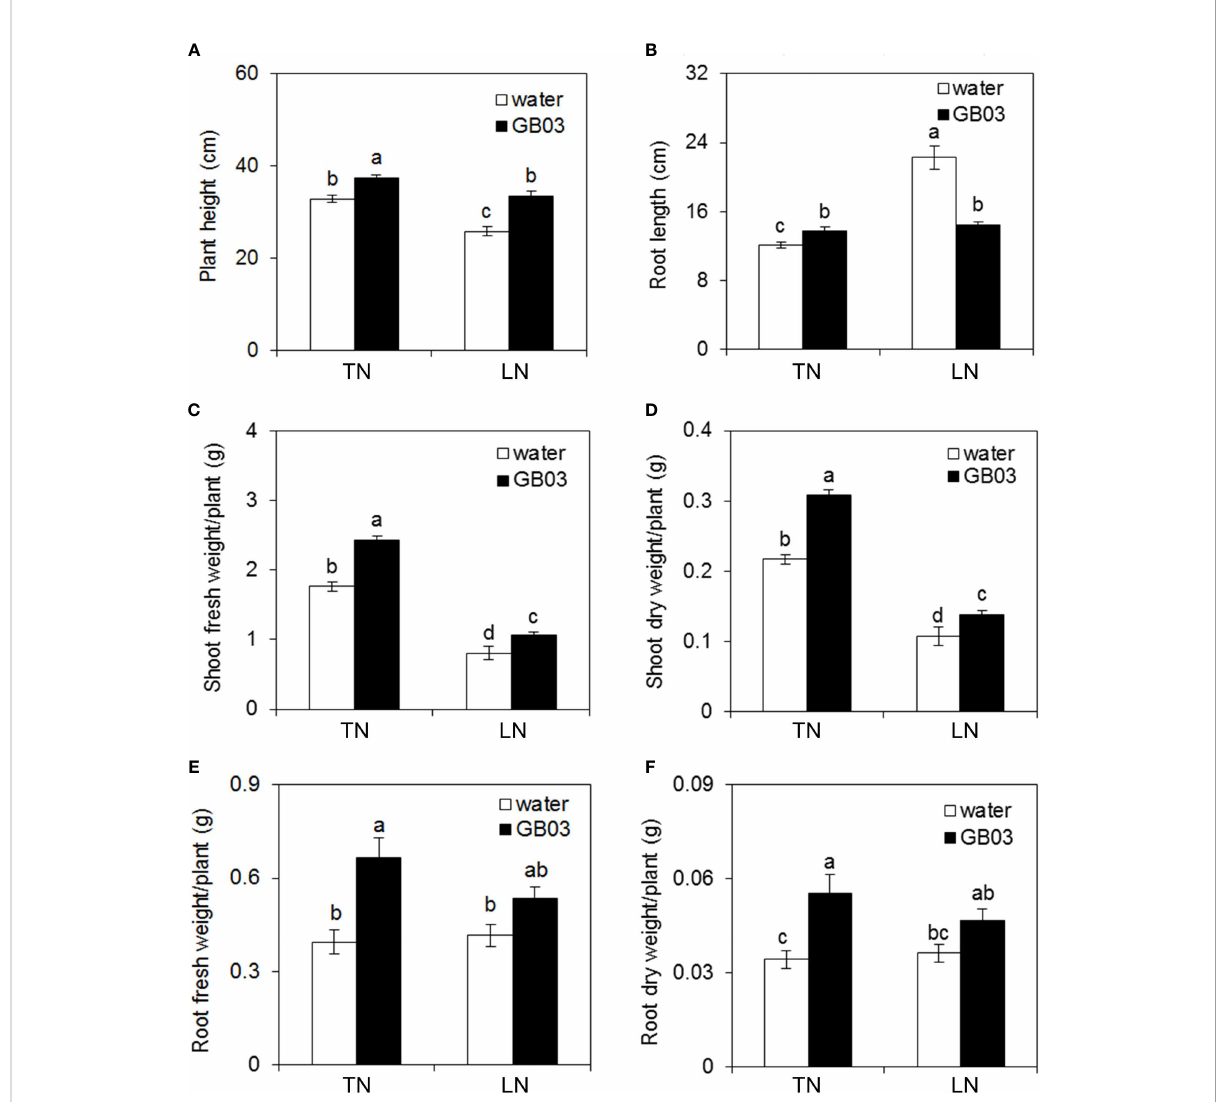
FIGURE 2 Effects of GB03 on tall fescue growth under various concentrations of NO 3- . (A) Plant height, (B) root length, (C) shoot fresh weight, (D) shoot dry weight, (E) root fresh weight, and (F) root dry weight. Values are means ± SE (A and B n = 30; C-F n = 8), and bars indicate SE. Columns with different letters indicate signi fi cant differences at p < 0.05 (Duncan ’ s